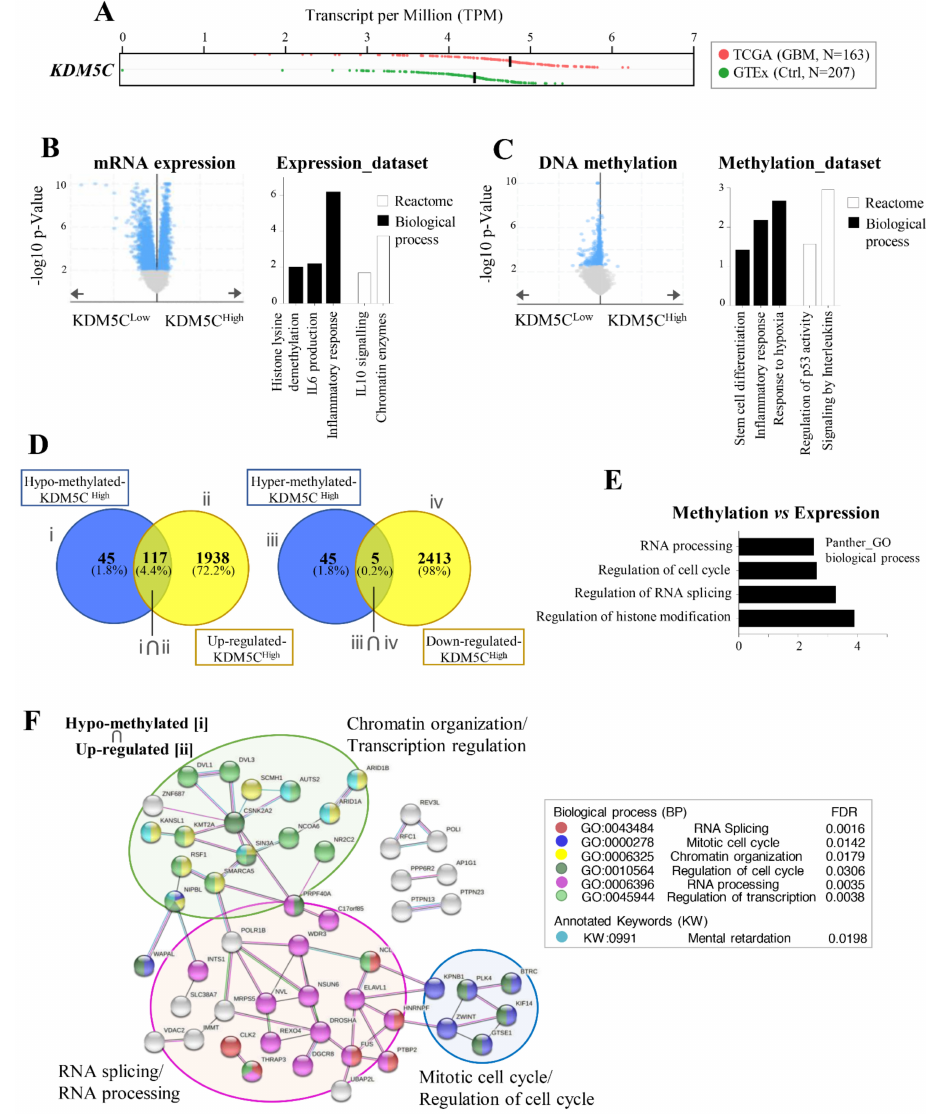
Figure 4. Features of the KDM5C Low and KDM5C High subgroups in the TCGA dataset. ( A ) KDM5C expression (transcript per million, RNA-Seq data) in the GBM samples (TCGA; N = 163) compared to control post-mortem brains (GTeX portal; N = 207). ( B , C ) On the left, volcano plots reporting differential mRNA expression and methylation between the two GBM subgroups (downloaded from cBioportal). On the right, bar graphs reporting the results of Gene Ontology and pathway analysis on differentially expressed ( B ) and methylated ( C ) genes between the two tumor subgroups. ( D ) Venn diagrams of hypomethylated/overexpressed genes and hypermethylated/downregulated genes in the KDM5C High cohort. ( E ) Gene Ontology analysis of DEGs regulated by methylation changes (DEGs_meth) in KDM5C High (KDM5C High /DEGs_meth) by using the Panther classification system (www.pantherdb.org; accessed on 1 June 2022). ( F ) Network analysis of protein–protein interactions for KDM5C High /DEGs_meth genes using the STRING